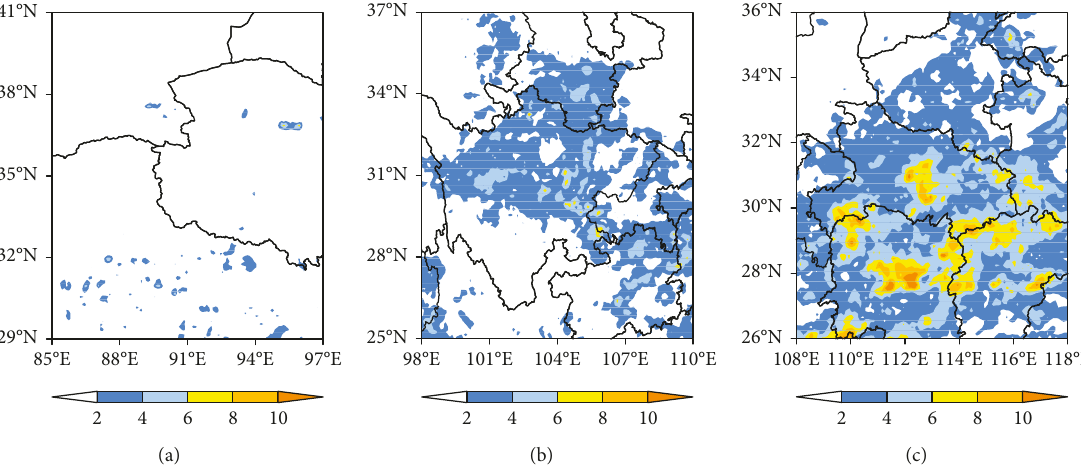
Figure 3: The distribution of the area-average precipitation triggered by the eastward-moving TPV category over different key regions: (a) TP; (b) ESTP; (c) MYR (shaded color represents precipitation (unit: mm)).